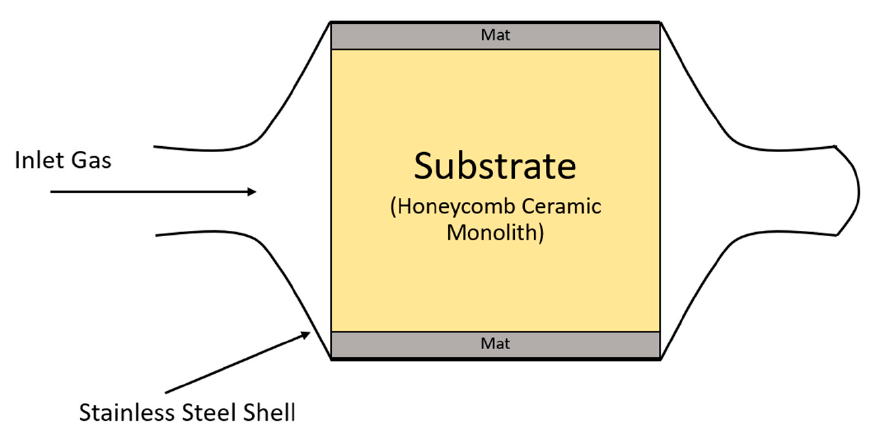
Figure 5. Diagram of converter with the mat. Adapted from [45].